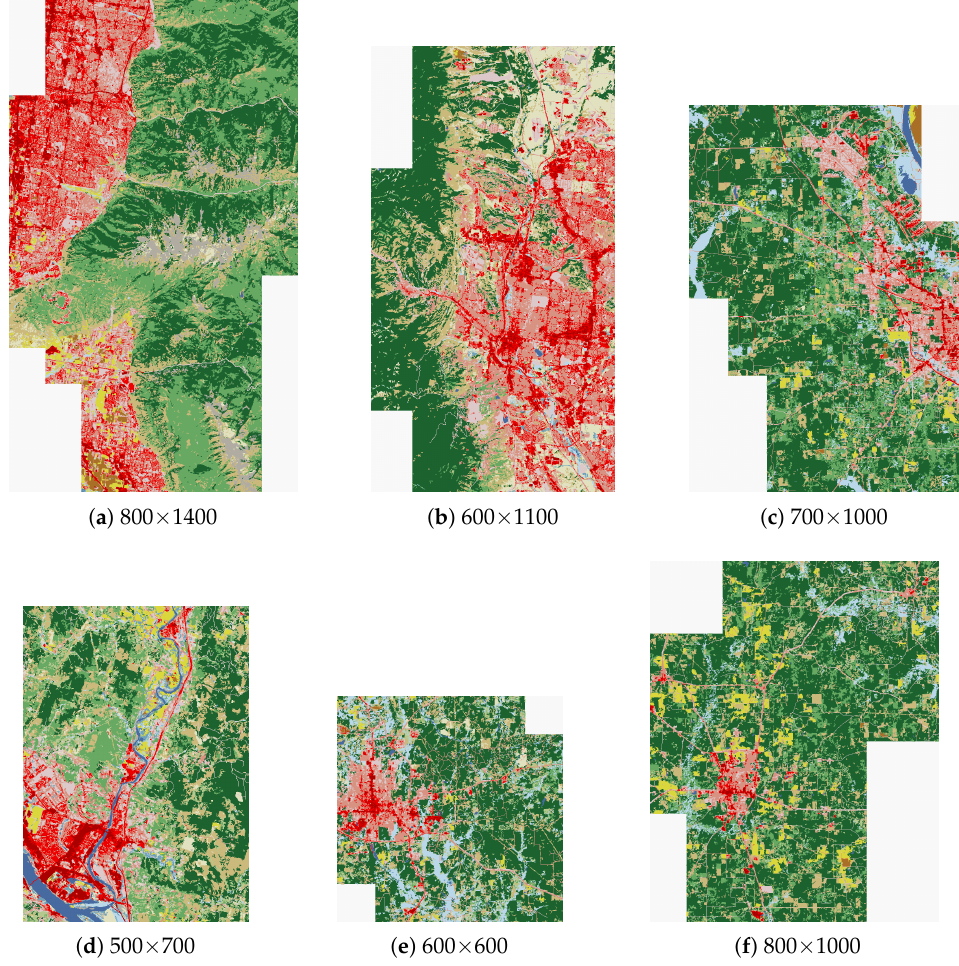
Figure 18. Top six retrieval results of reference III acquired by the use of the method proposed in [28]. Table 3. The geographic coordinates of the center pixels in the top six returned scenes with reference scene III. Coordinates included in the brackets were acquired by [28], and the others are the results of the proposed